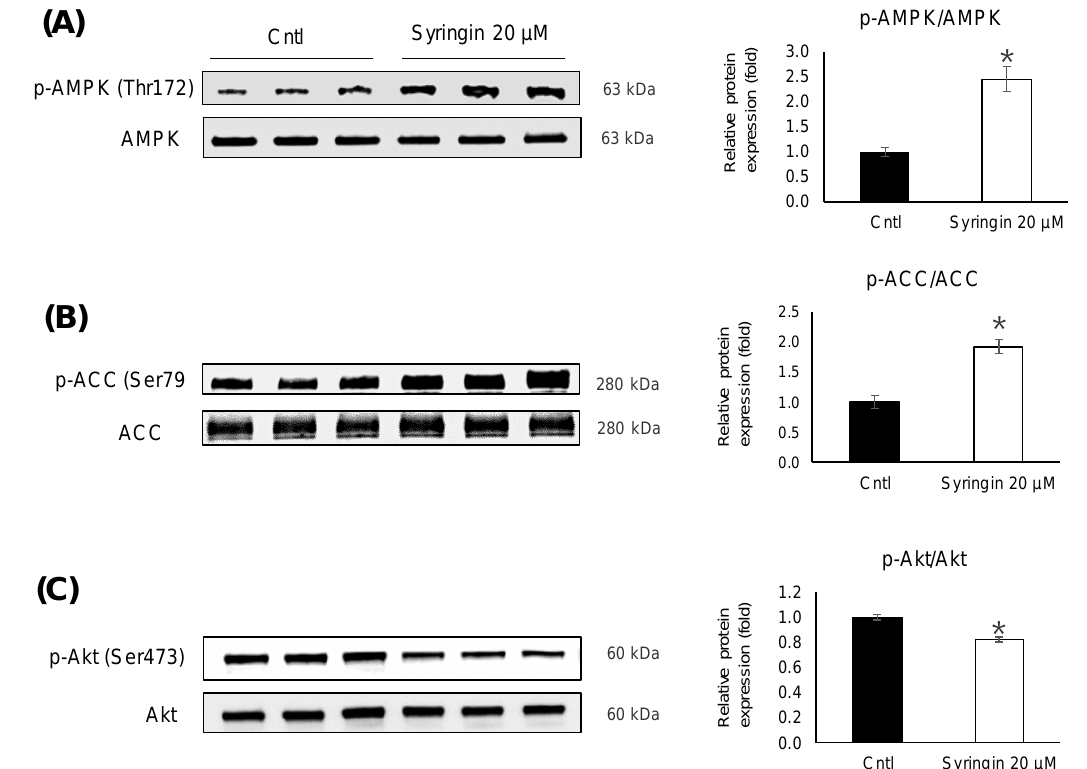
Figure 6. Effects of syringin on AMPK, ACC, and Akt phosphorylation during the differentiation of 3T3-L1 adipocytes. ( A – C ) Ratios of relative phosphorylation to total protein levels of ( A ) p-AMPK/AMPK, ( B ) p-ACC/ACC, and ( C ) p-Akt/Akt. The results are presented as means ± SEM of three independent experiments ( n = 3). The asterisk (*) indicates a significant difference between control and treatment groups by Student’s t-test. * p < 0.05 vs. control (Cntl).